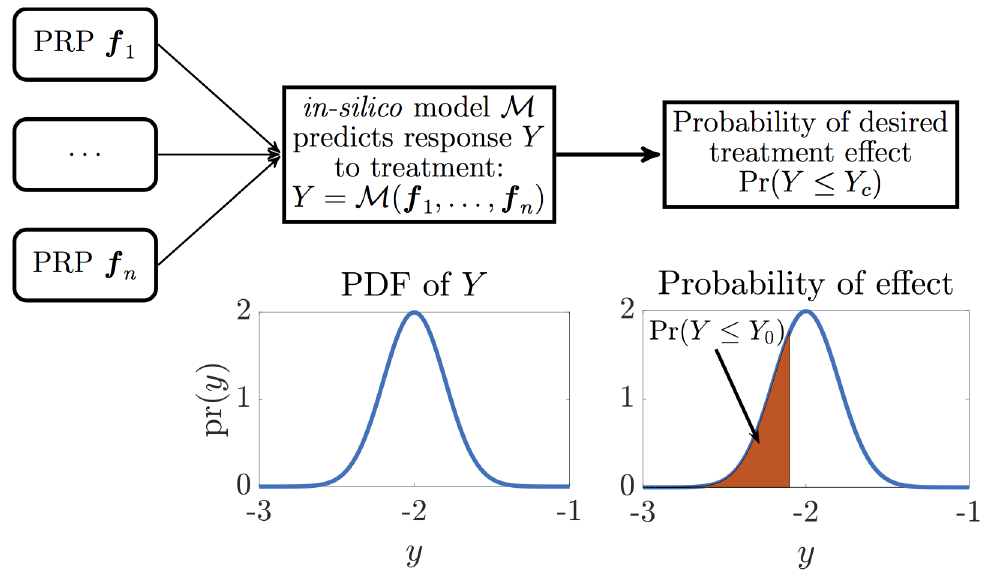
Fig 2. Modeling uncertainty in-silico . The paradigm of using in-silico modeling to make predictions about treatment effect under uncertainty about the physiological processes involved. Relevant physiological processes f 1 , ... , f are n identified, and a model M predicting response is selected. Because of uncertainty in the processes, they are modeled as random; hence the response Y is random, having PDF pr( y ). A desired effect is identified, for instance response less than a threshold Y . Its probability is the area under pr( y ) left of Y c c